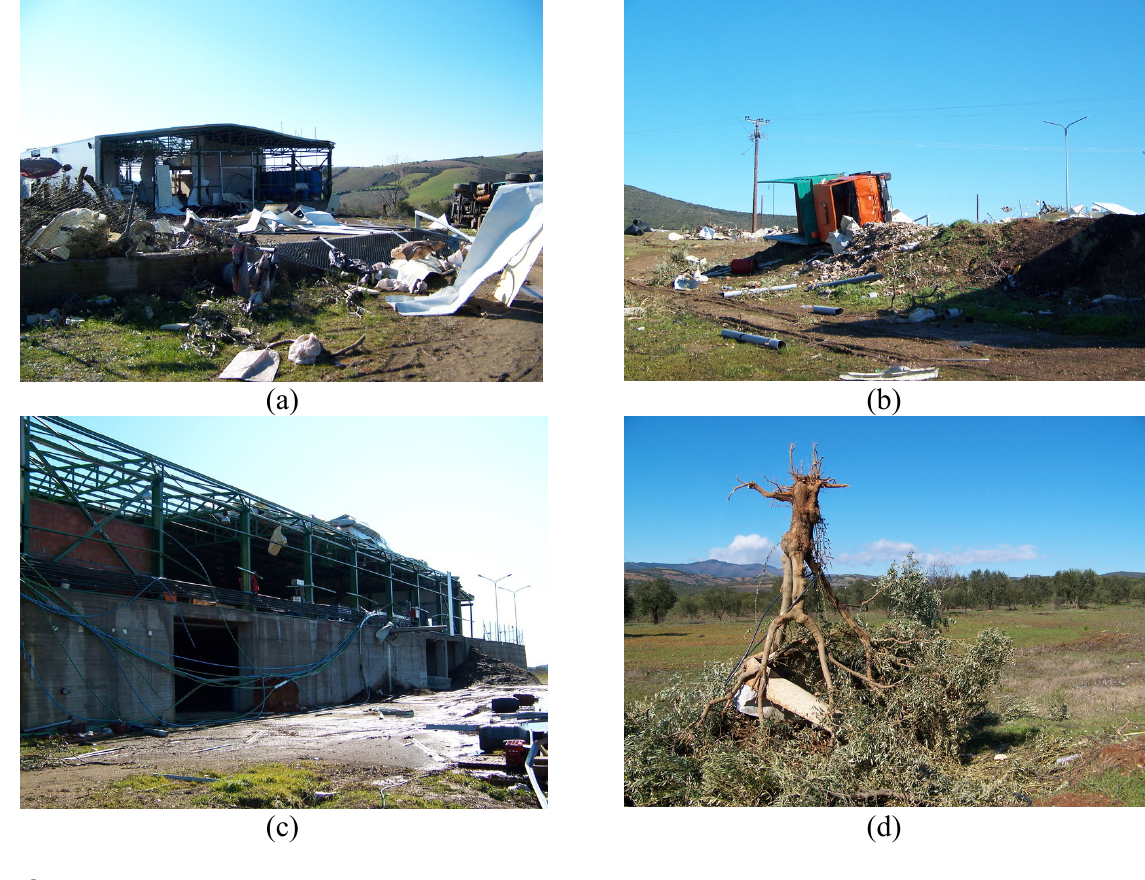
Figure 1. Tornado’s damages near Vrastama Chalkidiki on 12 February 2010 (Photos: http: // forum.snowreport.gr / forum posts.asp?TID = 23403&PN =